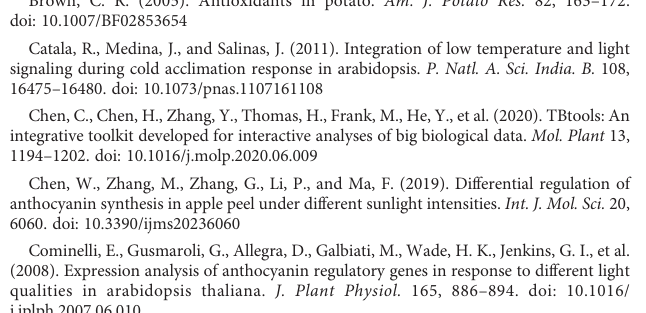
SUPPLEMENTARY FIGURE 2 Quantitative analysis of transcript levels of differentially expressed genes (DEGs) in RM-210 tubers light-induced. Each column represents the mean value ± standard error (n = 3). SUPPLEMENTARY FIGURE 3 Screening of StMYBA1-overexpressed transgenic lines. (A) Regeneration bud fromthemicrotuberofpotato. (B) Rootingscreeningoftransgeniclines. (C) The relative expression of the StMYBA1 gene in the transgenic lines. Each column represents the mean value ± standard error (n = 3). (D) Growth status of transgenic plants and the untransformed control. Bars=2